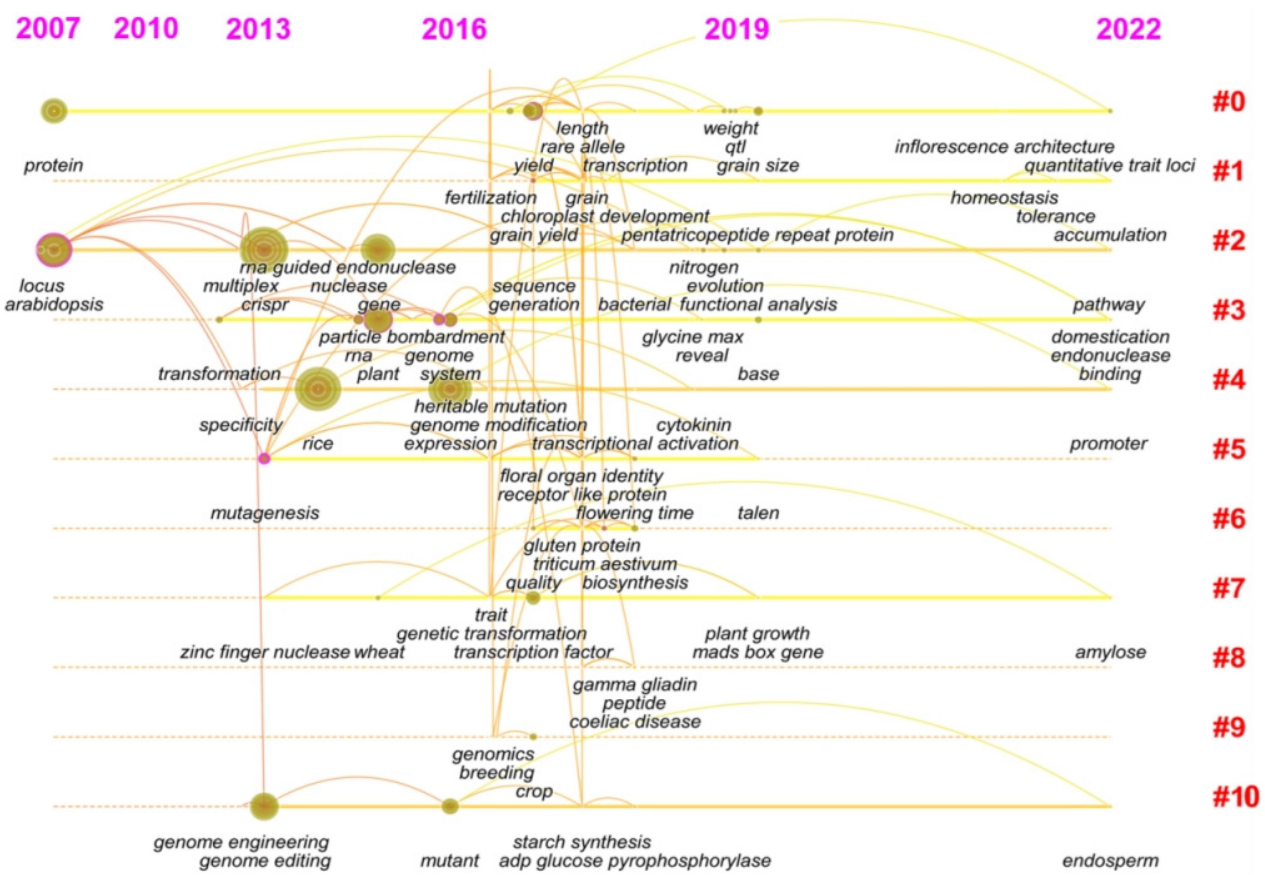
Figure 4. Timeline chart of keyword changes in the gene editing field from 2007 to 2021. Using the Timeline View clustering function in CiteSpace software, the dynamic frontier evolution map of the keywords in the gene editing field was obtained (Figure 4). Based on text clustering analysis, 10 clusters were obtained, namely #0, rice; #1, chloroplast development; #2, functional redundancy; #3, cpf1; #4, homologous recombination; #5, regulatory network; #6, the main food crops; #7, wheat; #8, gluten; #9, economic value; and #10, endosperm development. This shows that the application of gene editing to food crops and gene editing technology has become the research focus in recent years. Moreover, the functional redundancy of rice shows the longest cycle from 2007 to 2021.